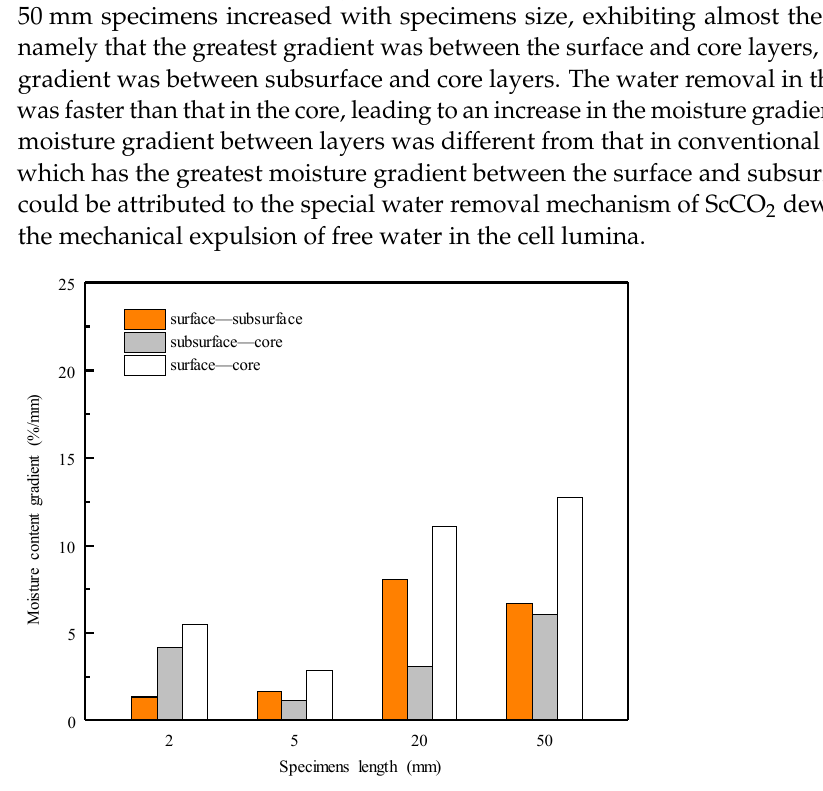
Figure 5. Moisture content distributions in the ( a ) tangential and ( b ) radial directions of specimens with lengths of 2, 5, 20, and 50 mm after the 12th dewatering cycles.